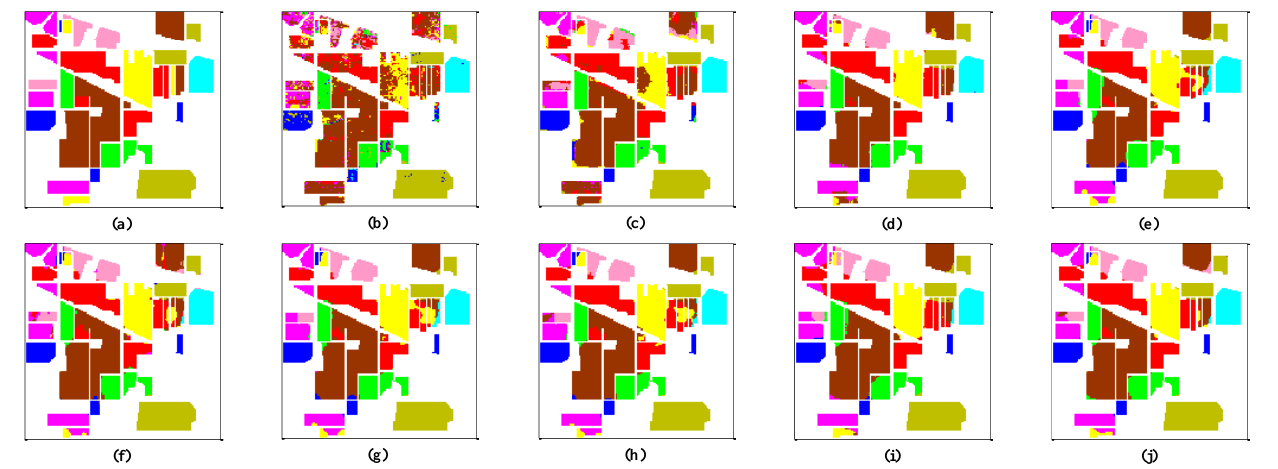
Figure 11. Land cover classification maps generated by different methods on the Indian Pines scene: ( a ) ground truth, ( b ) CRC, ( c ) JCRC, ( d ) CRC‑M, ( e ) JDKCRT, ( f ) KCRT‑CK, ( g ) WSSDKCRT, ( h ) WSSKCRT, ( i ) WSSJCRC, and ( j ) WSSJKCRC.